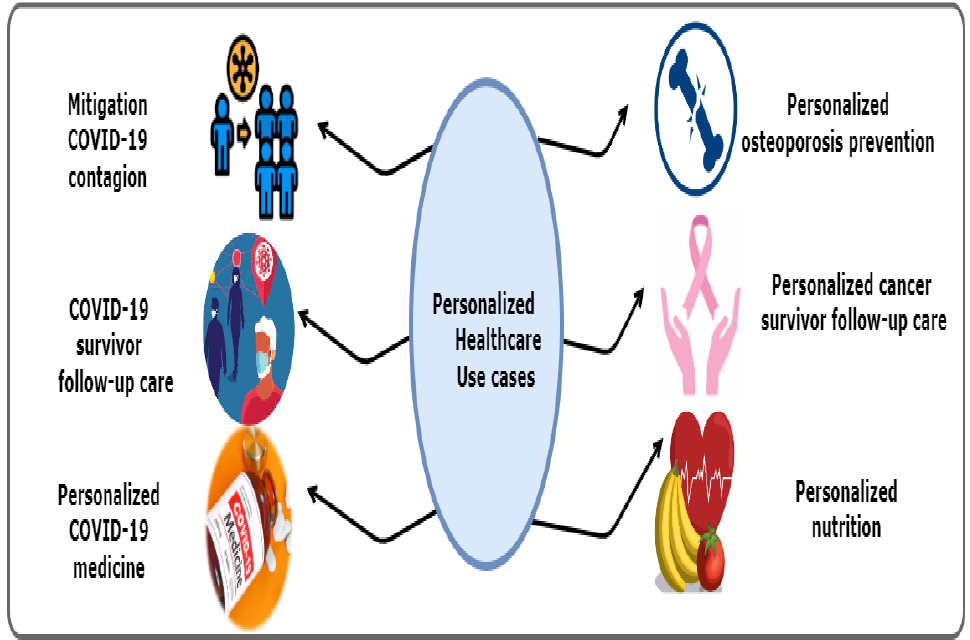
Figure 12. The use cases of using a personal digital twin for a smart personalised healthcare